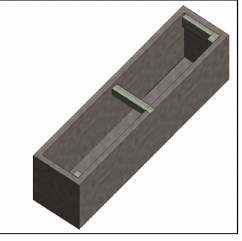
Figure 6. Automated modeling results of corridor 2F (without ceiling) in civil engineering